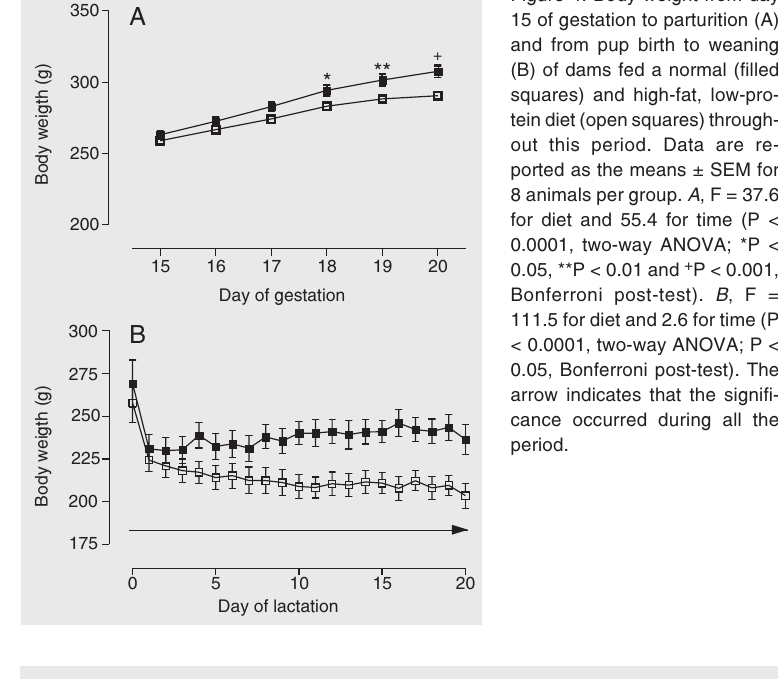
Table 2. Two-hour 131 I thyroid uptake and serum T 3 , T 4 and TSH concentrations on day 21 of dams receiving the control and the high-fat, low-protein diets. Control diet